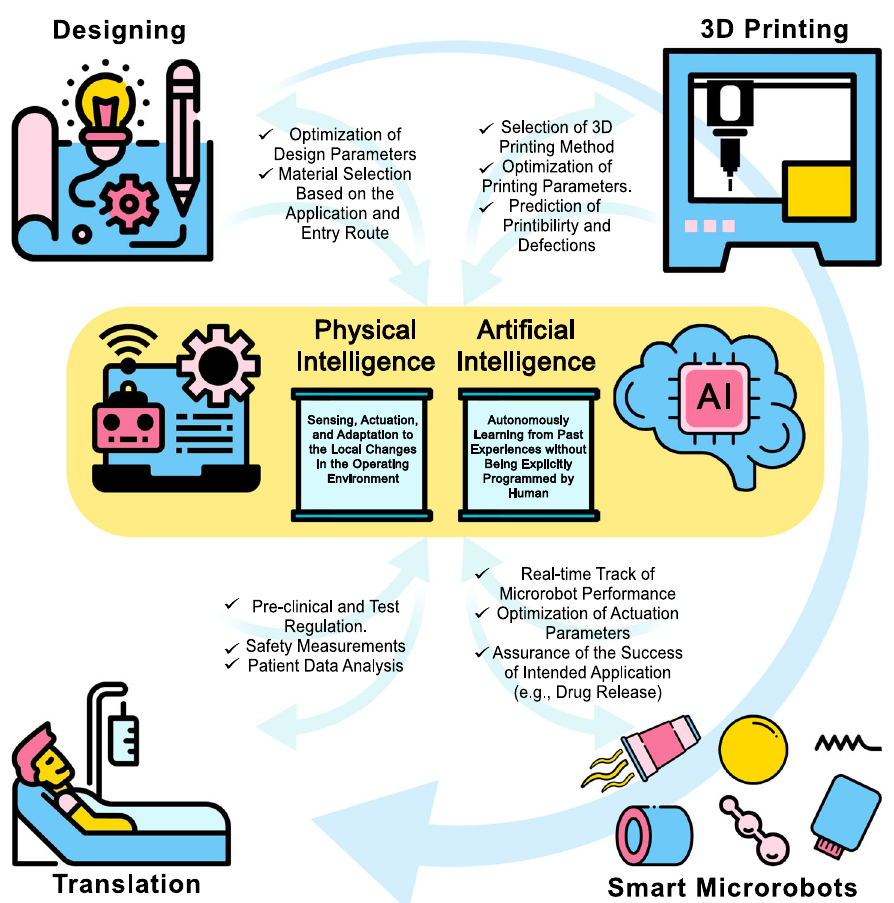
Fig.1|Aschematicviewofamicrorobotfrombenchtobedside. Thedesignand material-selection process can be assisted by AI and PI to design an